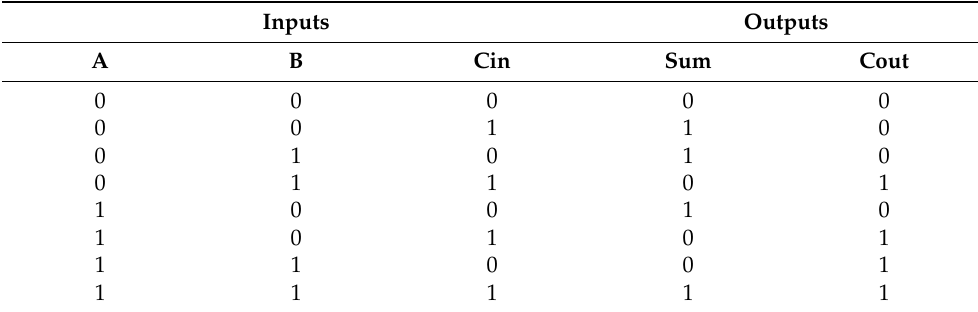
Table 1. Full adder truth